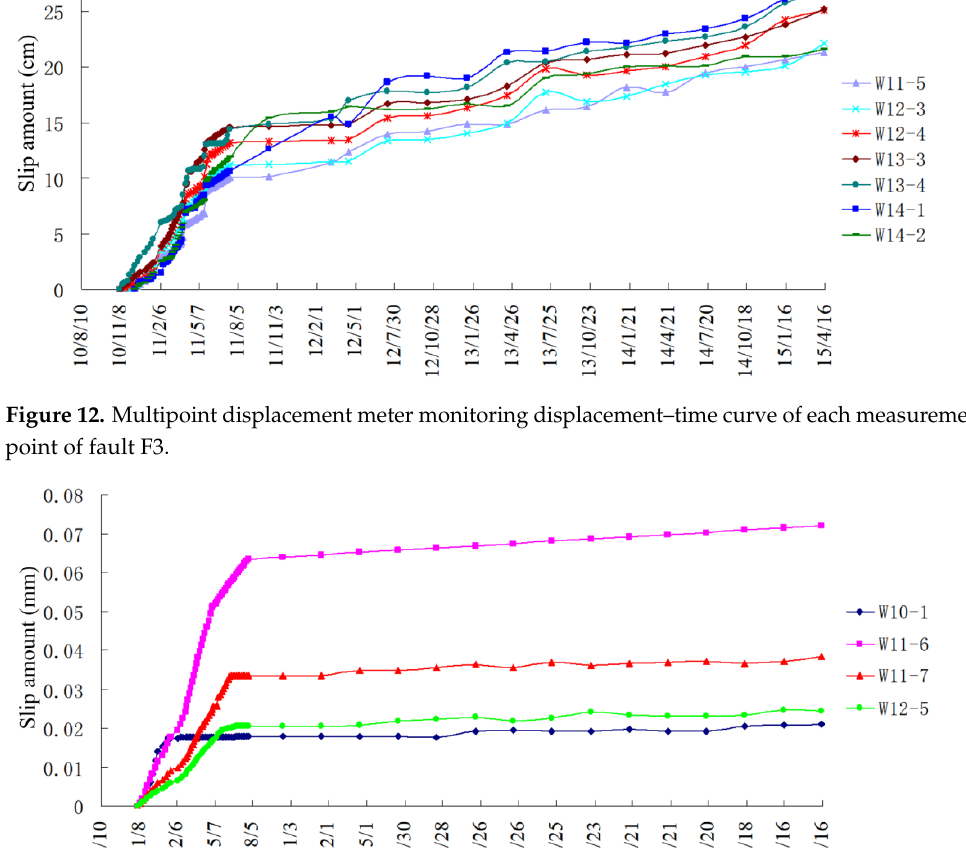
Figure 11. Slip–time monitoring curve of fault F2 observed by the mark line.